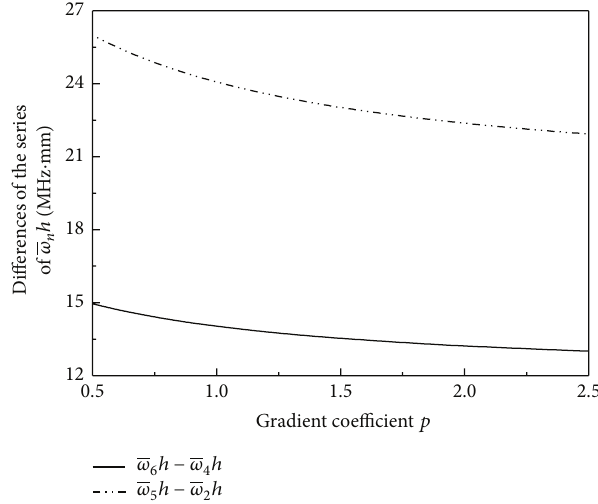
Figure 6: The relation between the differences of the series and the gradient